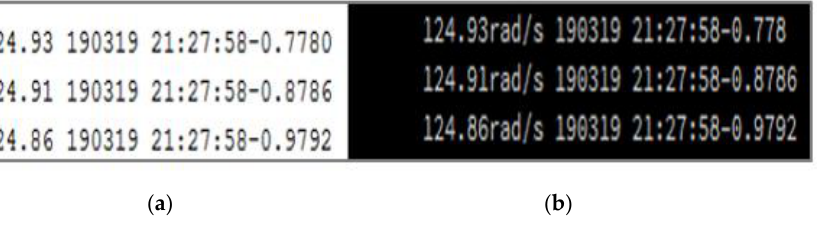
Figure 8. ( a ) Information printed from the serial monitor developed using Arduino Uno and ( b ) data reception in the processing software environment.